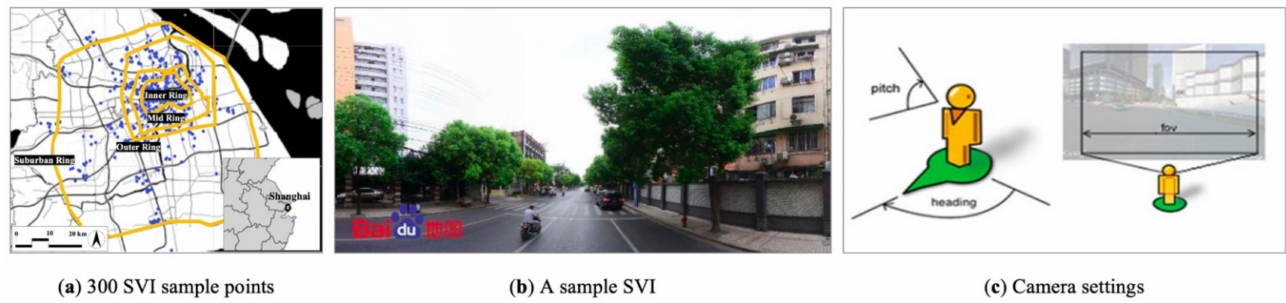
Figure 2. Downloading Baidu SVIs ( a ) SVI sample sites. ( b ) A typical SVI downloaded for this study. ( c ) The camera settings were controlled using “heading”, “FOV”, “pitch”, and